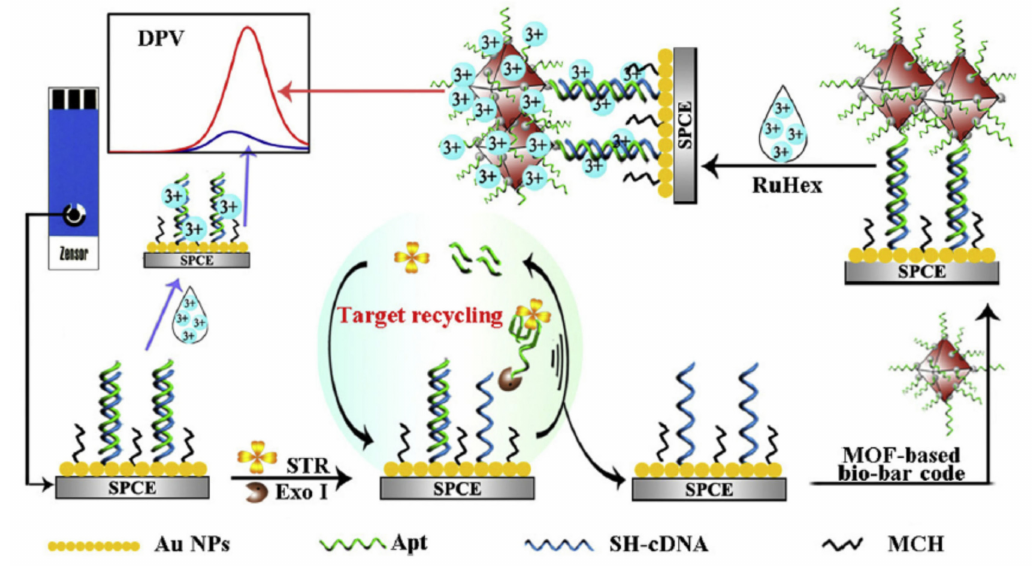
Figure 20. Schematic representation of an electrochemical aptasensor for the detection of streptomycin in milk. The signal was amplified based on target recycling amplification (TRCA). Reprinted from reference [28] with permission from